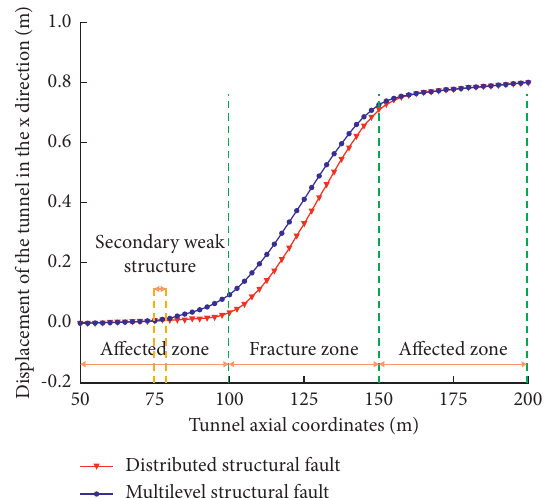
Figure 14: Displacement curves of tunnel across distributed structure and multilevel structure.